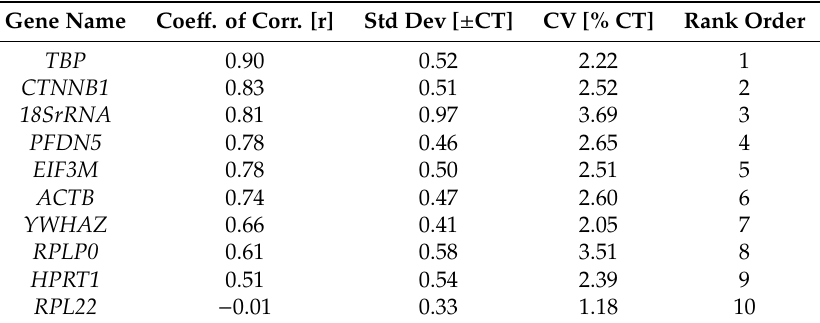
Table 3. Expression stability of reference genes by BestKeeper